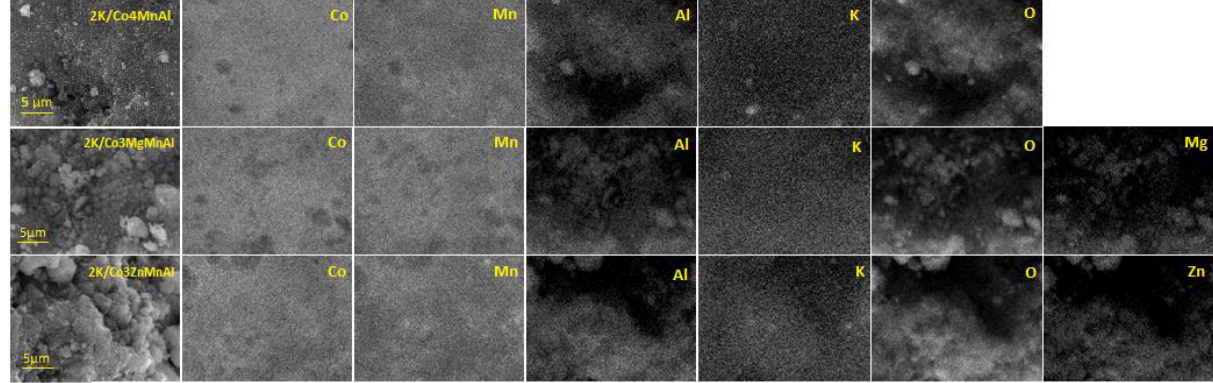
Figure 5. Component dispersal over mixed oxide catalysts from SEM (EDAX).